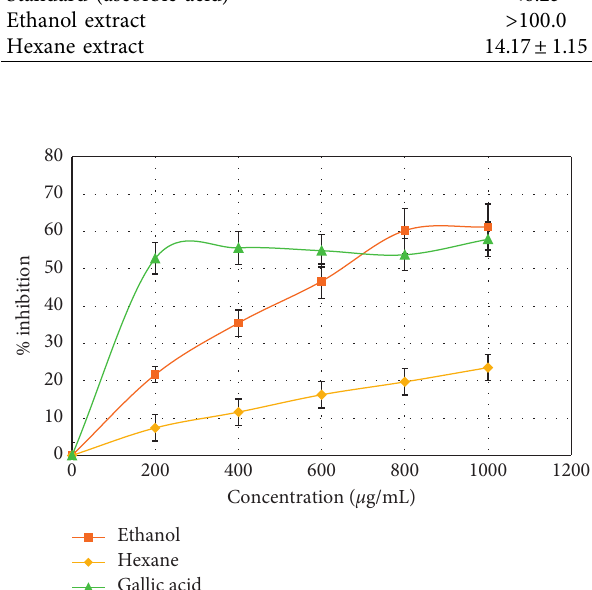
Figure 3: Hydrogen peroxide radical scavenging capacity of the extracts of O. basilicum and gallic acid.